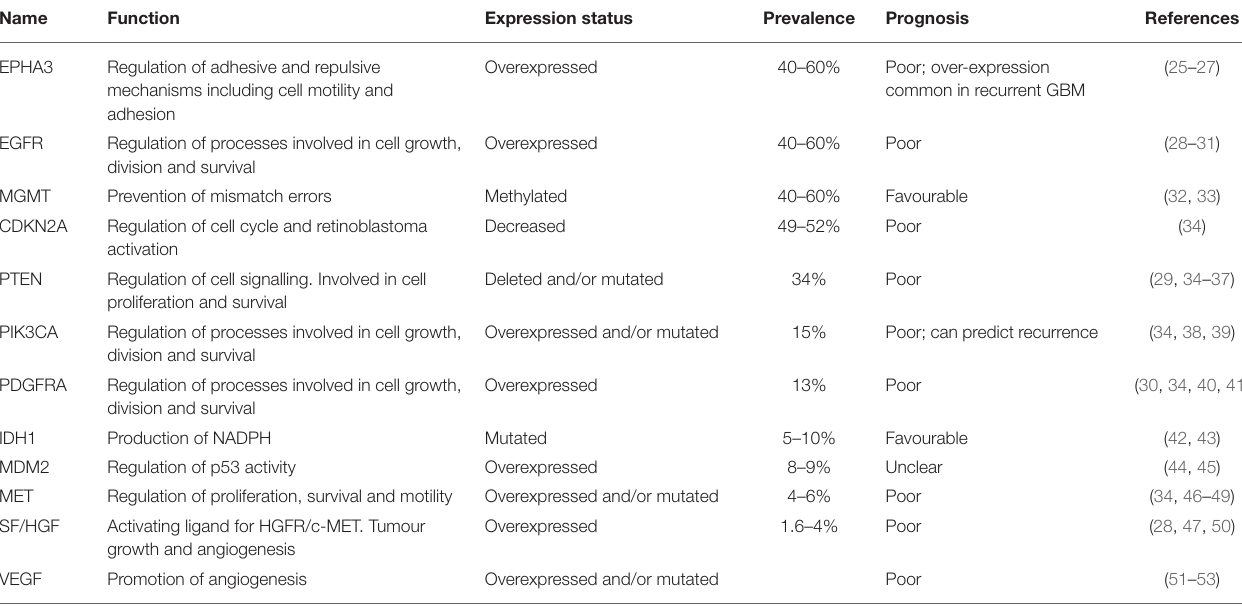
TABLE 1 | Commonly identified genetic alterations in